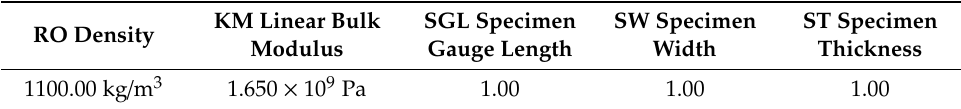
Table 6. Software parameters applied in Ls Dyna to describe the Simplified Rubber Material (SRM) model.